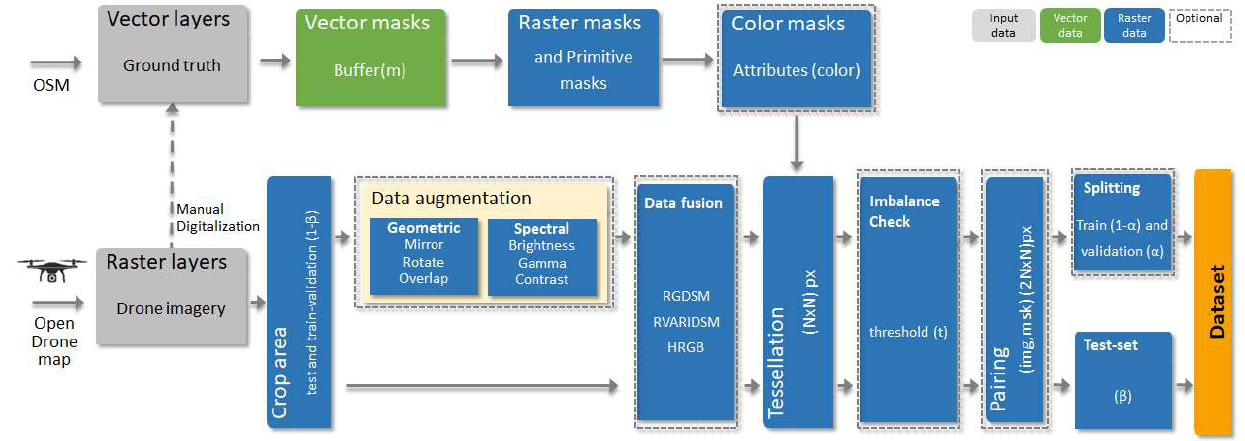
Figure 1. GIS pipeline to produce GeoAI datasets from drone imagery.